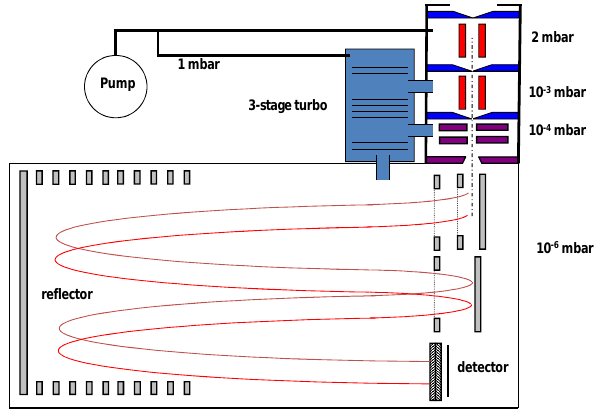
Fig. 1. Schematic of APi-TOF. First inlet chamber is pumped with separate scroll pump, other chambers are pumped with 3-stage turbo pump. Pressure drop in chambers is from 2mbar in the first cham- ber to 10 − 6 mbar in the time-of-flight region. Red bars represent two quadruple ion guides and green bars ion lens stack to guide ions to TOF.